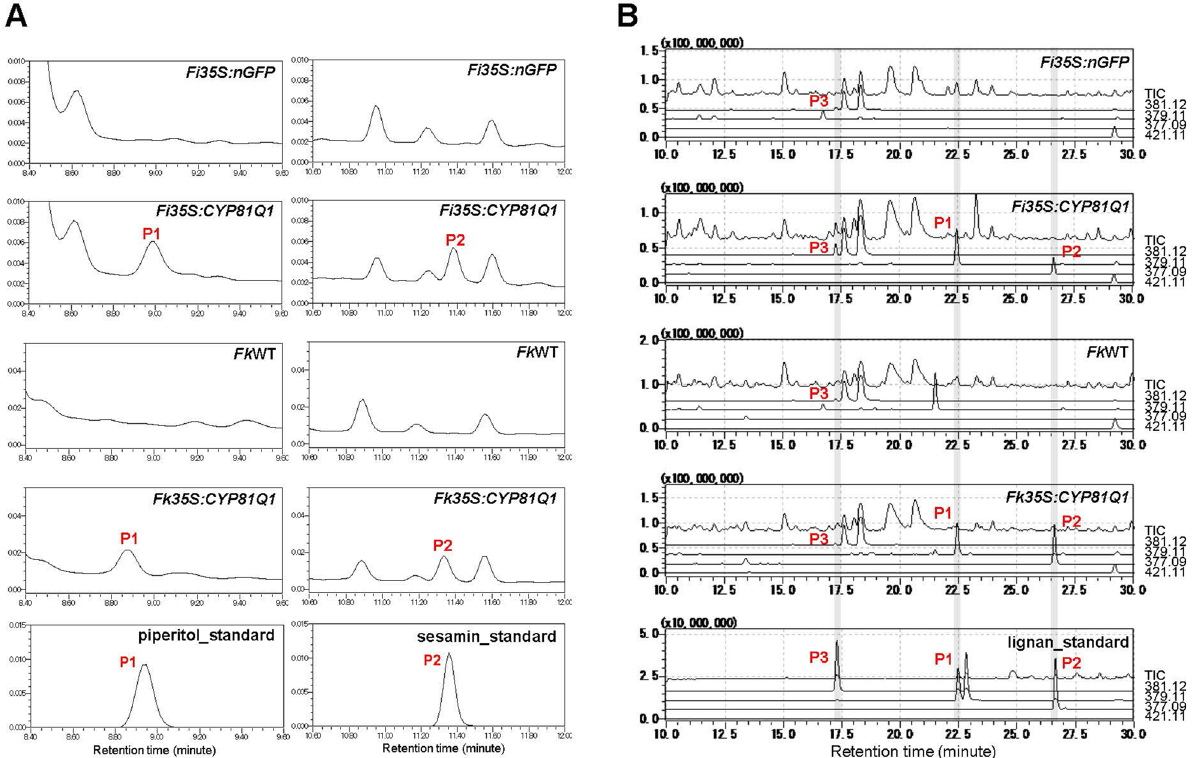
Figure 4. HPLC ( A ) and LC–MS ( B ) analysis of control and Pro35S:CYP81Q1 plants. Chromatograms showing specific accumulation of (+)-piperitol (P1) and (+)-sesamin (P2) in the Pro35S:CYP81Q1 leaves. In ( B ), pinoresinol (P3); m/z = 381.12, piperitol; m/z = 379.11, sesamin; m/z = 377.09, 3 ′ -ethoxysesamin; m/z = 421.11, TIC total ion current.